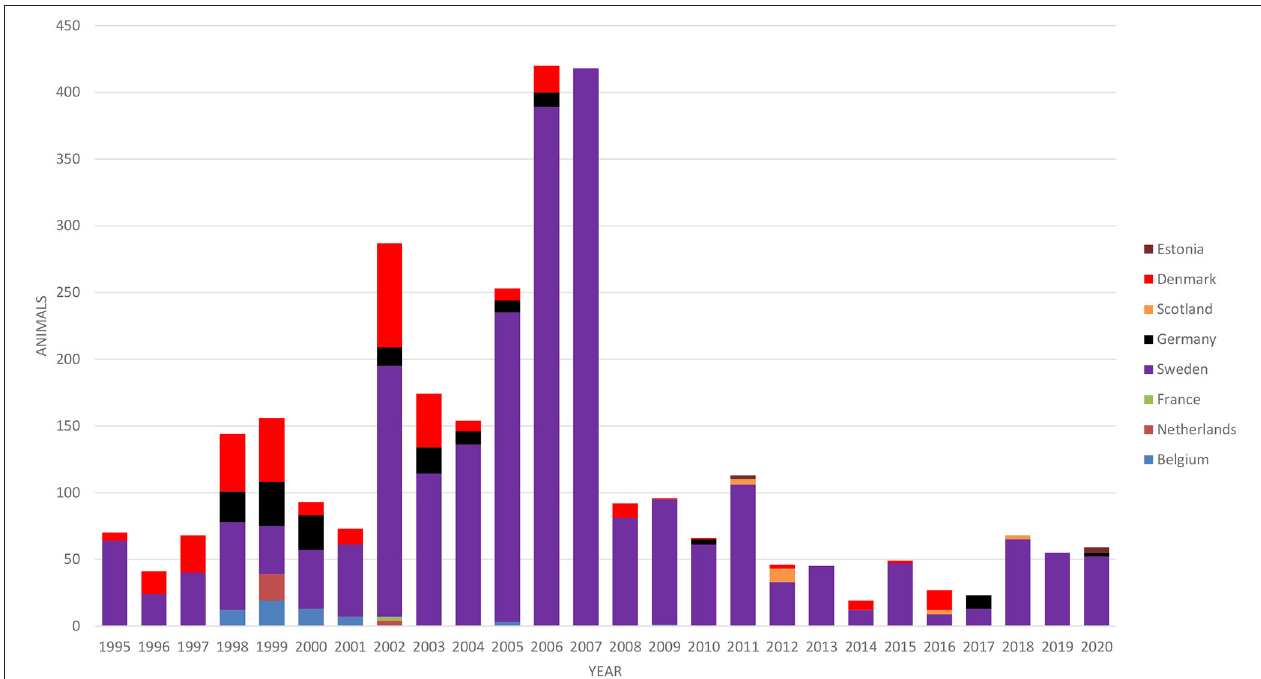
FIGURE 3 | Number of cattle imported to Finland according to the country of origin in 1995–2020.